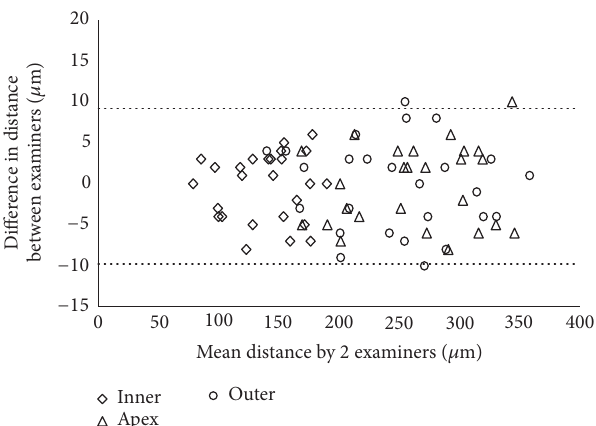
Figure 4: Scatterplot showing the differences between examiners’ measurements of the distance from apex to anterior corneal surface ( 󳵻 ), from inner corner to posterior corneal surface ( ◊ ), and from outer corner to posterior corneal surface ( I ). Individual differences between examiners are plotted against the mean value obtained by both examiners together. The 95% LoA interval is represented with dotted lines.